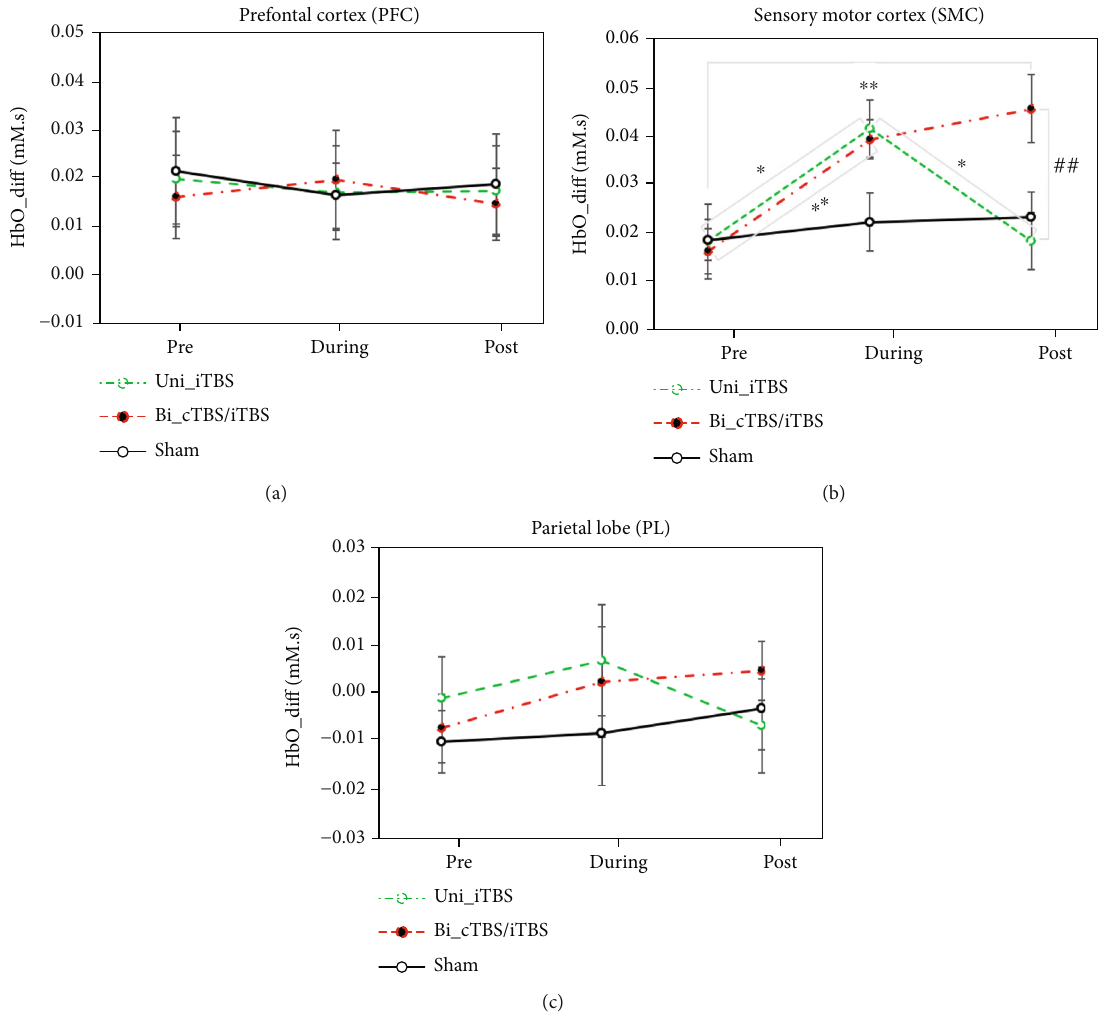
Figure 9: Group average of △ HbO_di ff ( ± SEM) in the (a) PFC, (b) SMC, and (c) PL measured in the pre, during, and 10 min poststimulations of the three HD-TBS sessions. ∗ p ≤ 0 : 05 and ∗∗ p ≤ 0 : 01 indicate a signi fi cant di ff erence among three phases of each HD-TBS session. # p ≤ 0 : 05 and ## p ≤ 0 : 01 indicate a signi fi cant di ff erence among three HD-TBS sessions in the same